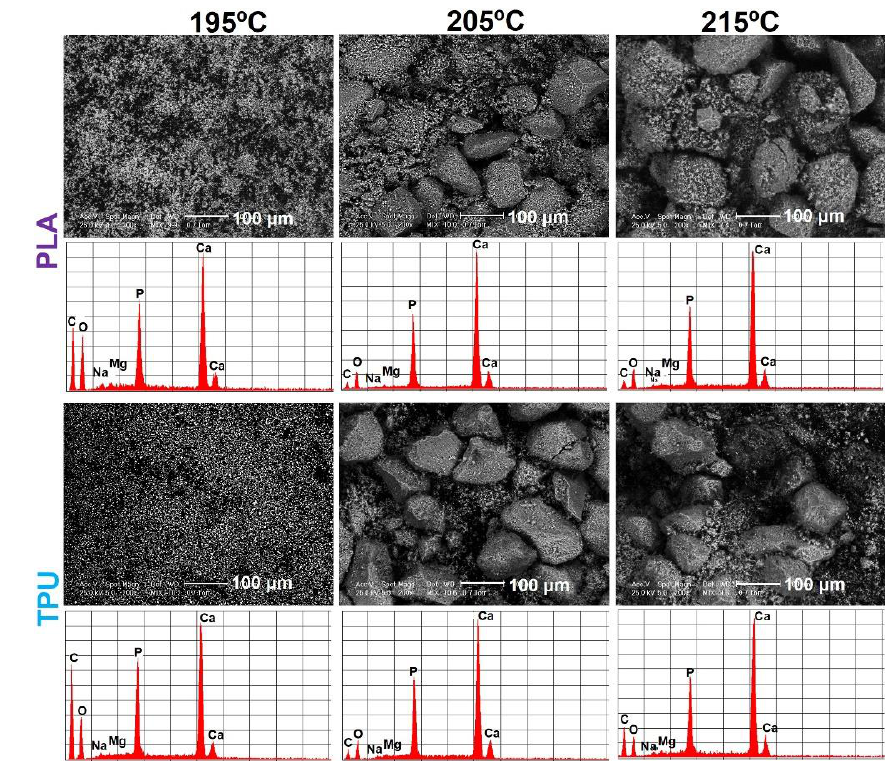
Figure 2. Preliminary morpho-compositional characterization of polylactic acid (PLA) and thermoplastic polyurethane (TPU) polymer coated with hydroxyapatite (HA) particles at 195, 205, and 215 °C.